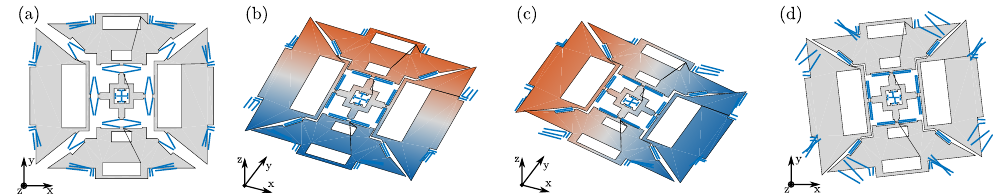
Figure 10. Modal shapes of the layout optimized by solving (P2) (Figure 8c): drive ( a ), pitch ( b ), roll ( c ), and yaw ( d